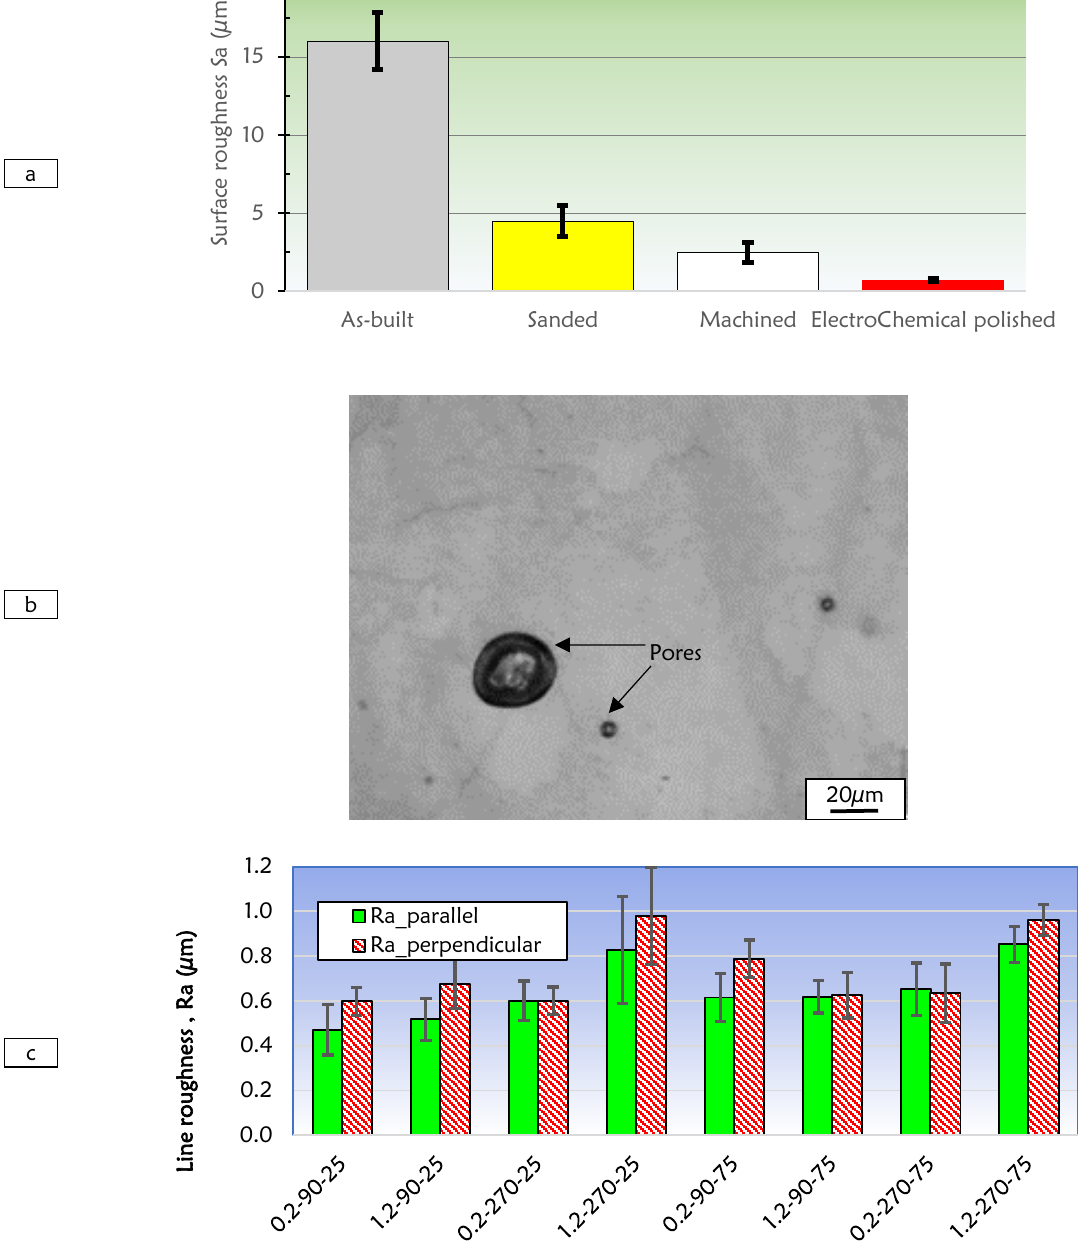
Figure 25: Surface finish SLM IN718 after electrochemical polishing: (a) Comparison of surface finish after different post processing techniques, (b) Unpolished pores on mirror finished surface, (c) Effect of electrochemical polishing parameters on surface finish. Measurement in two directions on surface; the parameters codes: current density (A/mm 2 ) - time (s) - duty cycle (%)